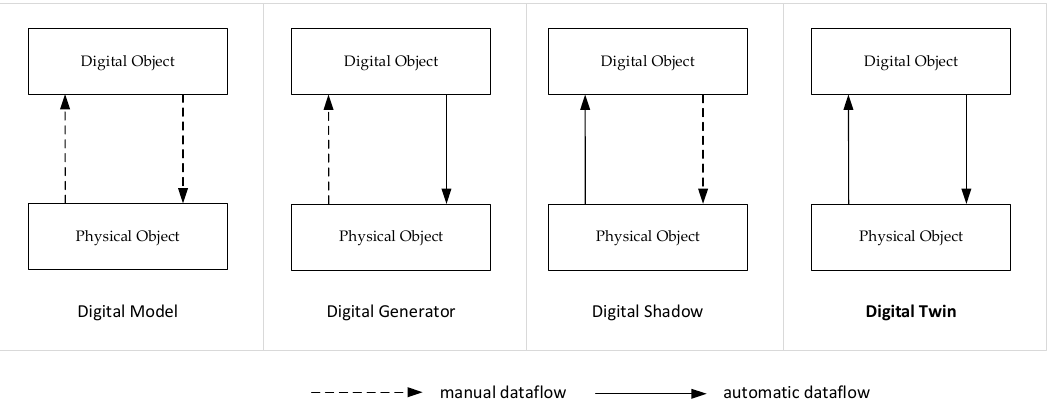
Figure 4. Identified relationships between digital object and physical object.